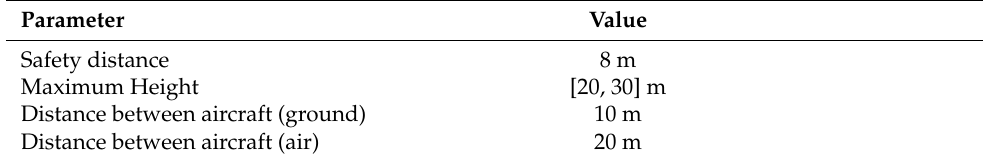
Table 1. Simulation